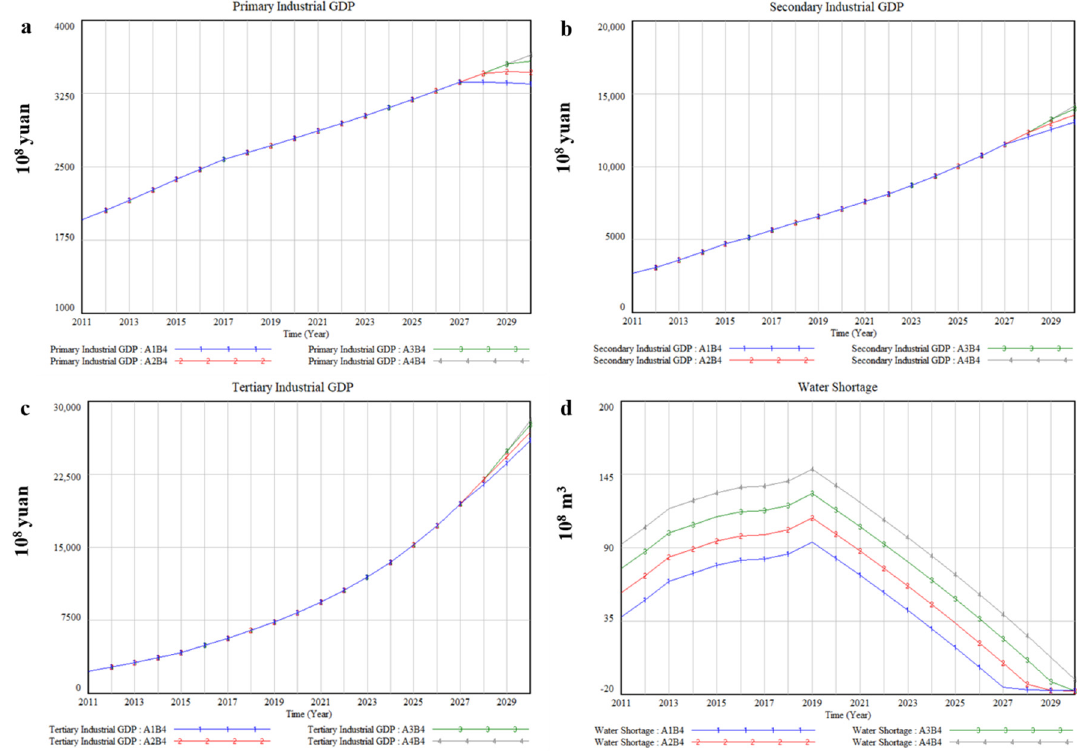
Figure 9. The simulation results of socio-economic and water impacts of 4 water diversion quantity from transboundary river basins under B4, ( a ) Primary Industrial GDP, ( b ) Secondary Industrial GDP, ( c ) Tertiary Industrial GDP, ( d ) Water Shortage.